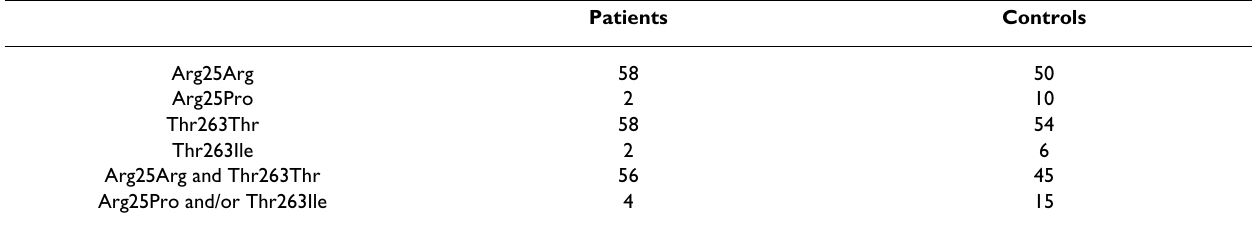
Table 2: There was a significant difference in Arg25Pro polymorphism between patient and control groups using Yates corrected Chi- square test (p < 0.035). The different distribution at codon 263 failed to be significant, but summarizing the individuals, who were homozygous at both codons, compared with individuals, who where heterozygous either at codon 25 or at codon 263 or at both codons, the difference between the patient and control groups was even more striking (p <